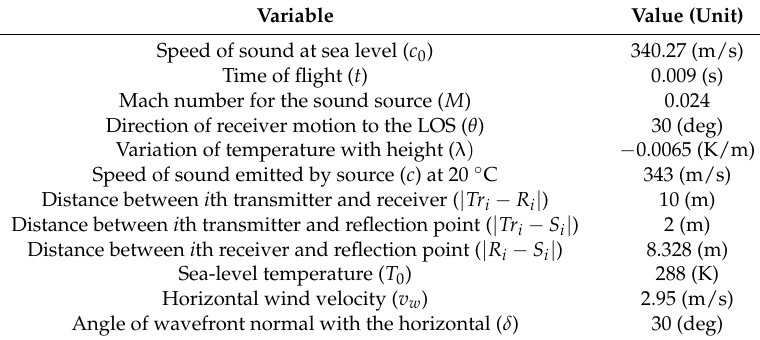
Table 3. Ranging